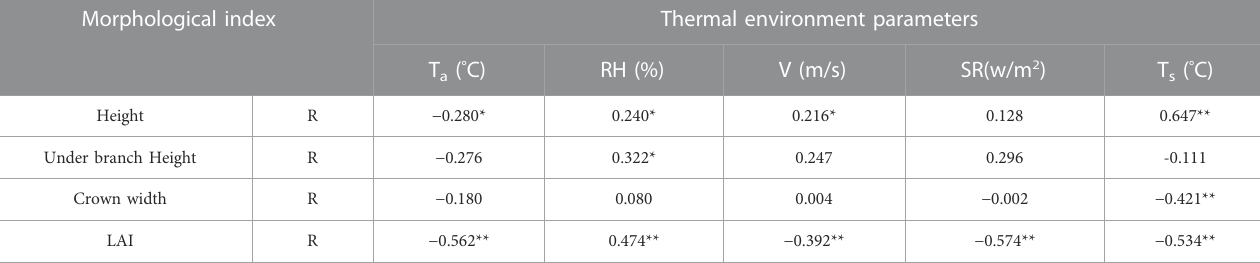
TABLE 5 Correlation between arbor morphological indexes and thermal environmental parameters. Morphological index